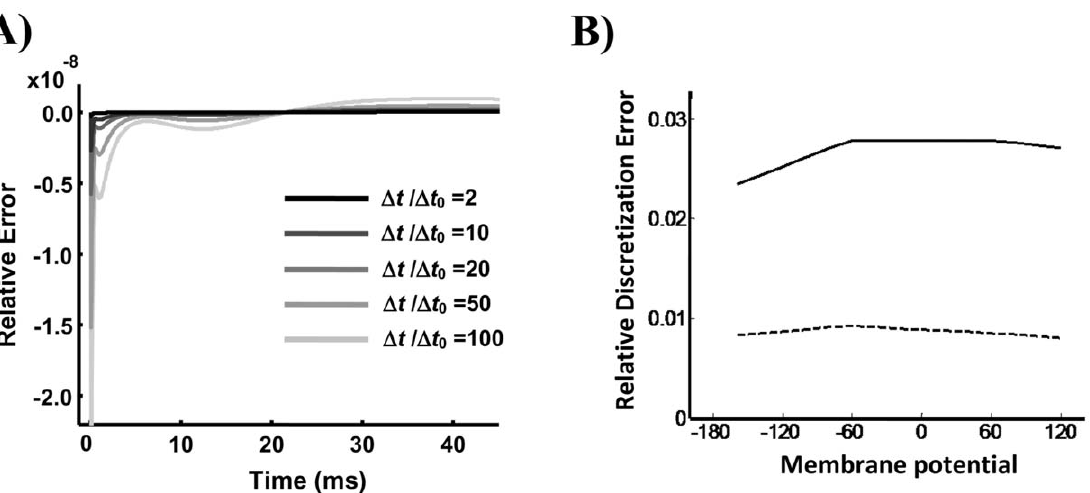
Figure 5. Finite Difference (FD) error in the numerical simulation. A ) Time variations of the FD error for different integration steps. Each curve shows the integral over the configuration space of the difference between the solution with a given time step ( D t ) and the solution with the finest time step ( D t 0 =50 ns) as a function of time. FD simulations are reasonably accurate when they converge. D t =2.5 m s was chosen in the simulations. B ) Maximum relative discretization error in energy landscapes at different membrane potentials.